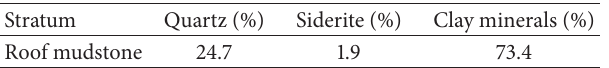
Table 1: X-ray diffraction analysis of roof mudstone. Stratum Quartz (%) Siderite (%) Clay minerals (%) Roof mudstone 24.7 1.9